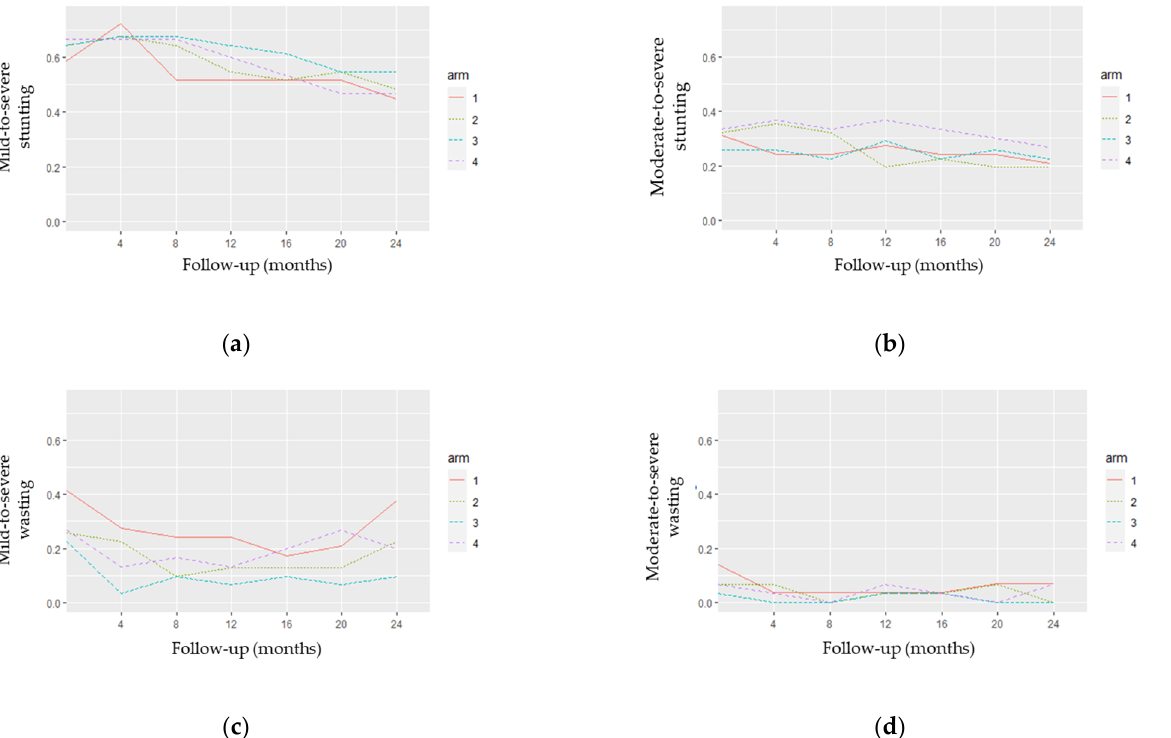
Figure 4. Observed stunting and wasting profiles by arm: ( a ) mild-to-severe stunting; ( b ) moderate- to-severe stunting; ( c ) mild-to-severe wasting; ( d ) moderate-to-severe wasting.